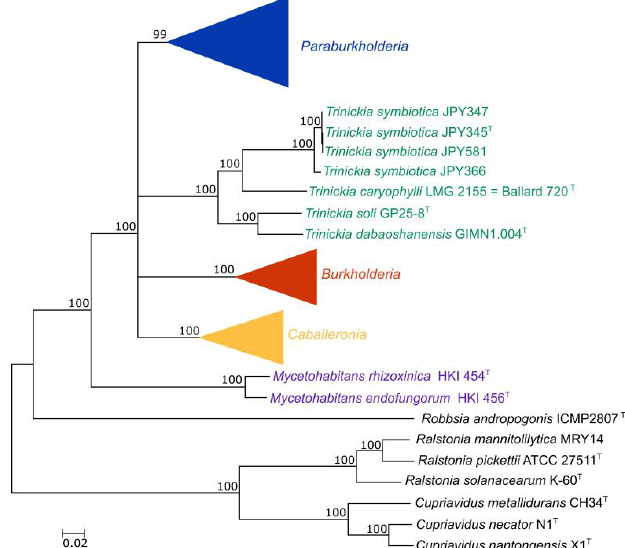
Figure 1. The compressed and collapsed maximum-likelihood (ML) phylogeny of the amino acid sequences of 106 concatenated genes for the 122 strains used in this study of available Burkholderia sensu lato genomes showing the positions of the newly-described genera Mycetohabitans and Trinickia vis-à-vis the previously established genera Burkholderia , Caballeronia , and Paraburkholderia . The scale bar indicates the number of changes per site. All branches with support values below 80% were